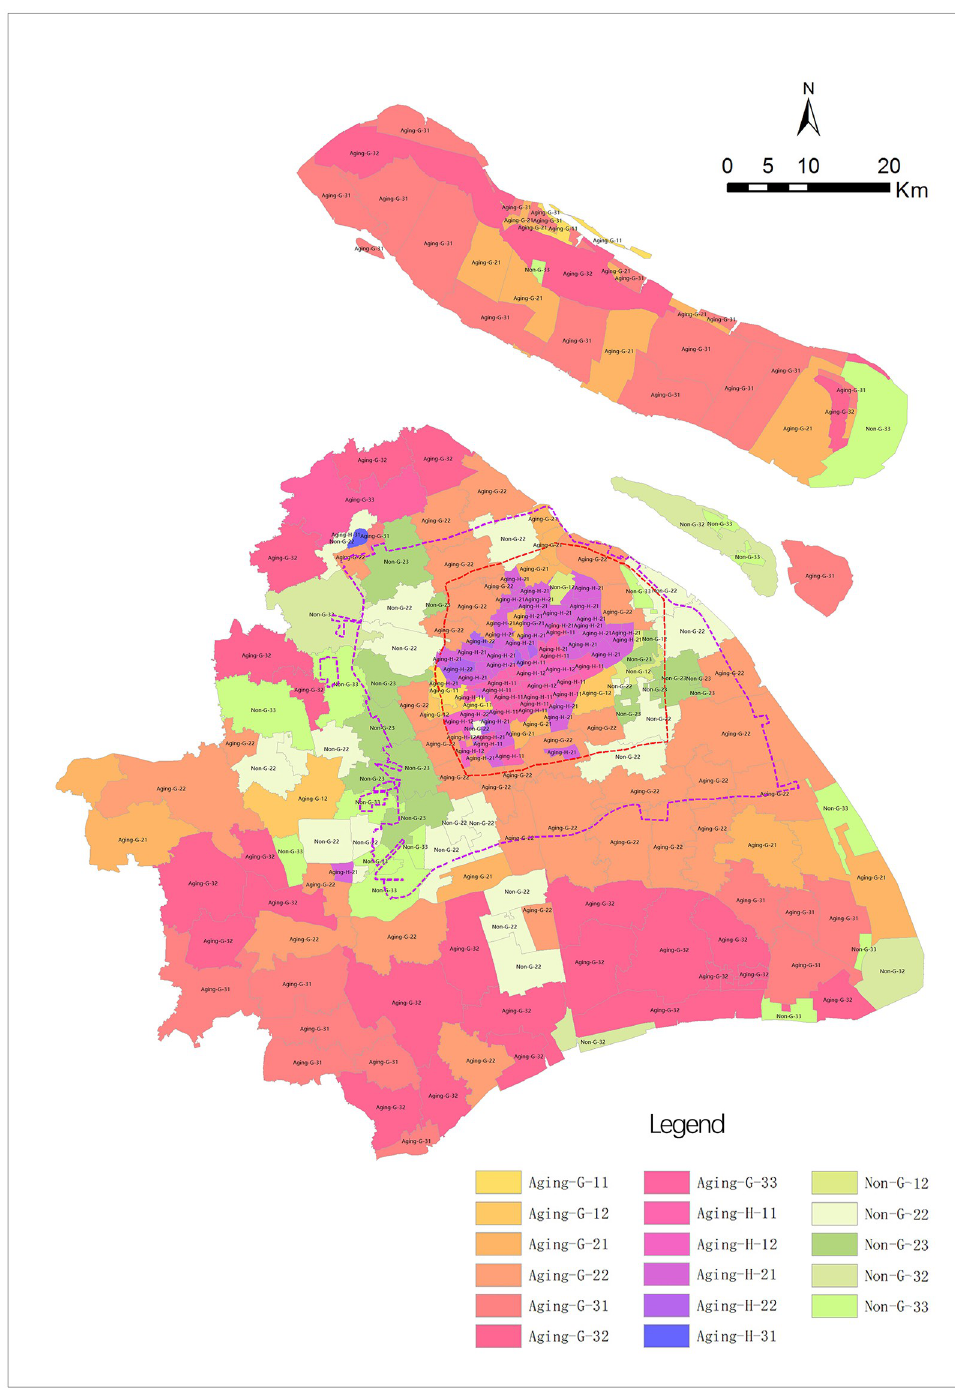
Fig 2. The spatial pattern of community differentiation in Shanghai. Source: Created by the author based on the base map of Shanghai from the Open Street Map(OSM) geographic data platform(https://www.openstreetmap.org/).